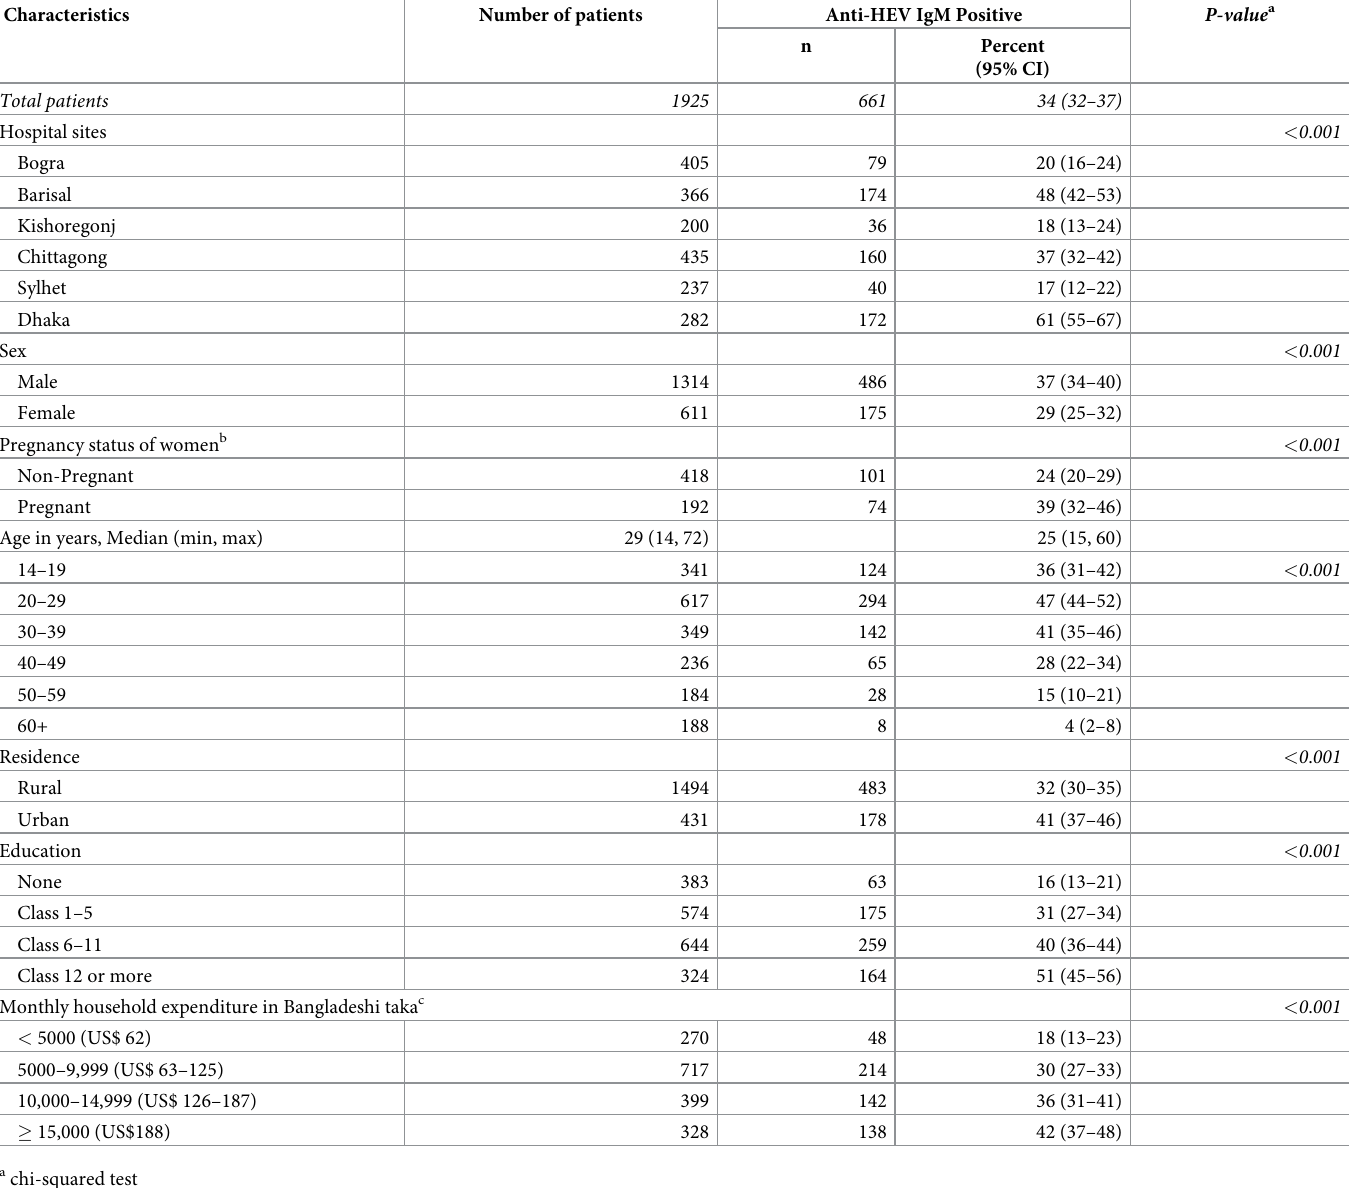
Table 1. Hepatitis E serological test results by demographic characteristics of patients with acute jaundice in six tertiary hospitals in Bangladesh, December 2014– September 2017.